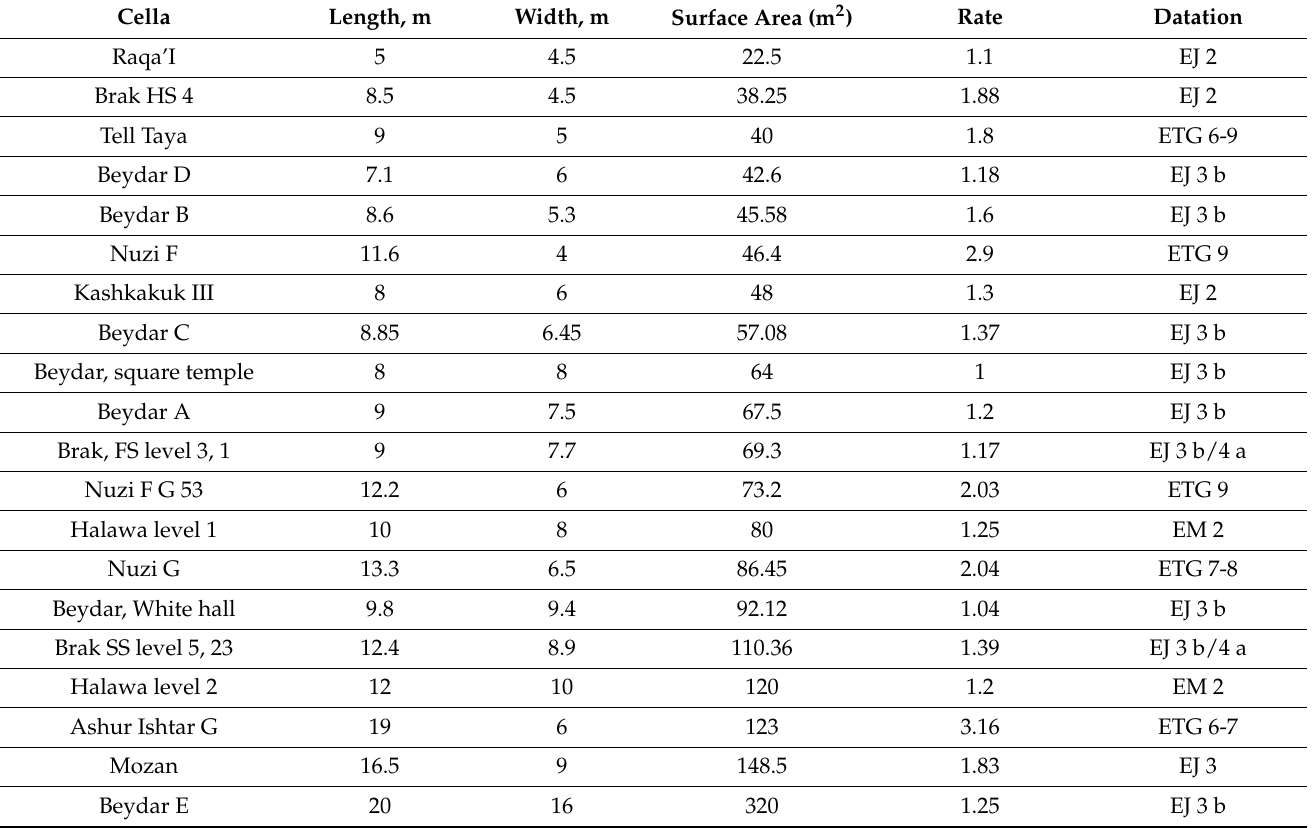
Table 4. Northern Mesopotamia, ceremonial rooms’ length and width, ordered by surface